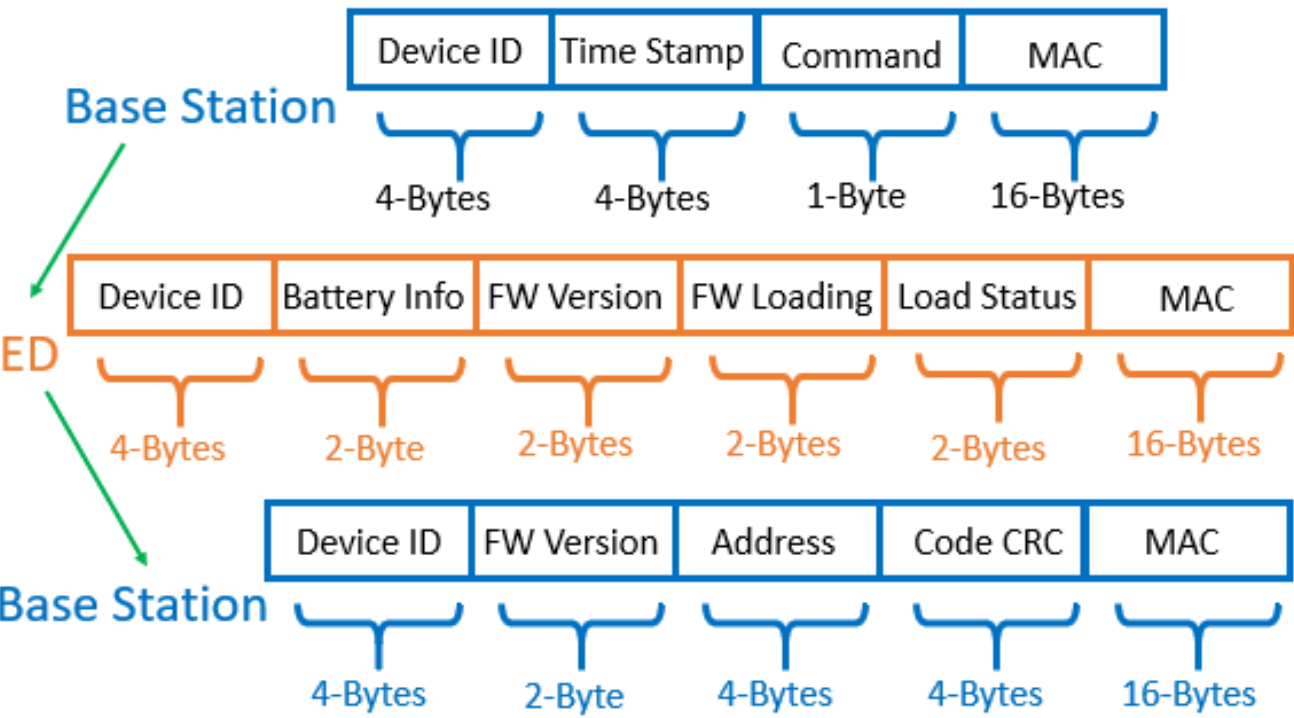
Figure 3. The packet structures for exchanging data during the initialization